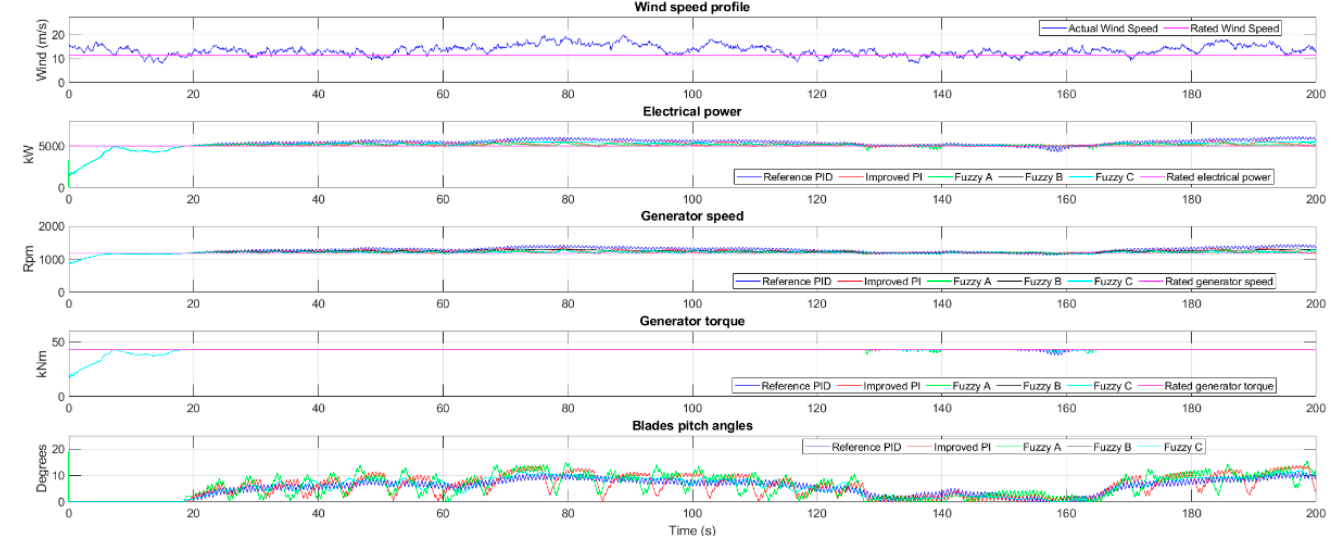
Figure 14. Comparison of the evaluated controllers for a wind profile of 13 m/s.